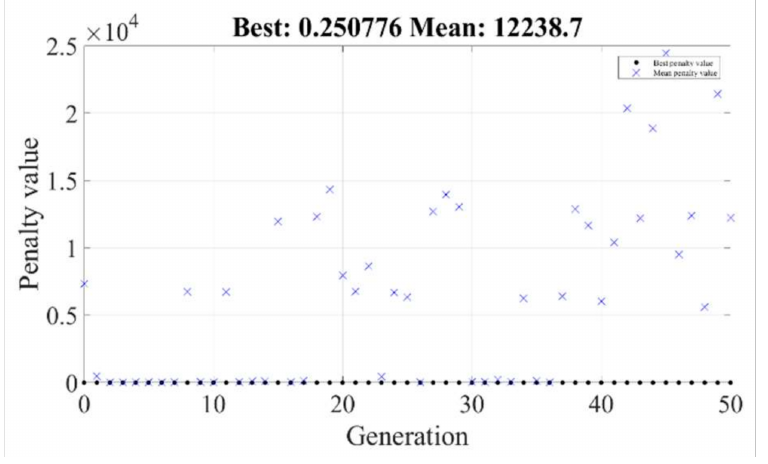
Figure 4. The convergence of single GA optimization method for